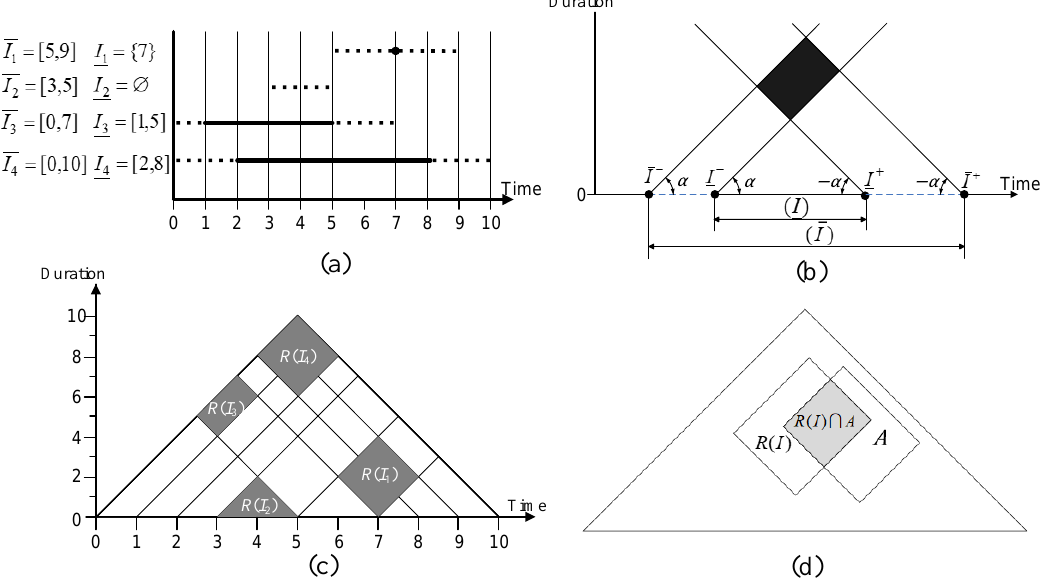
Figure 7. Representation of rough time intervals in the TM. ( a ) The linear representation. ( b ) Constructing a rough time interval in the TM. ( c ) Intervals in (a) in the TM. ( d ). Overlap between a query zone A and a rough time interval R ( I ) (adpated from [17]).